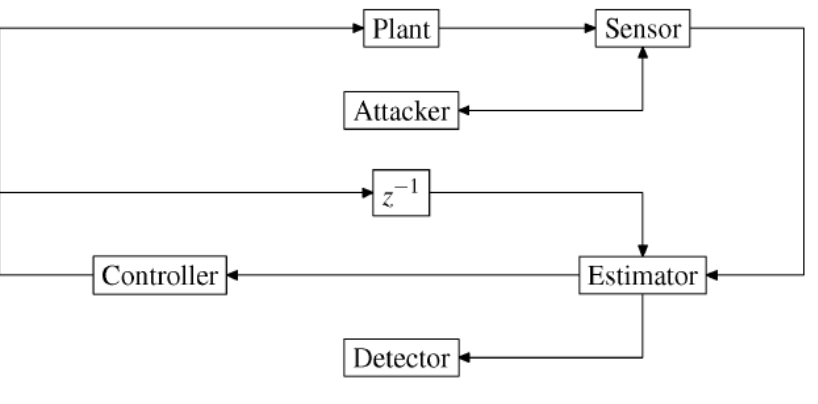
Figure 7. FDIA general block diagram.